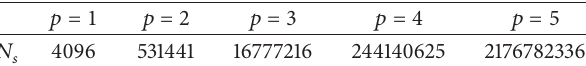
Figure 4: The range of geometric uncertainty. Table 2: The number of samples of the projection based NIPC method with 𝑝 increasing ( 𝑛 = 12 ).